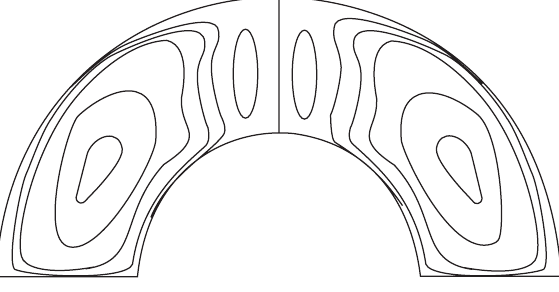
Figure 4.6. Contours of the meridional streamlines. Taylor vortex flow at Re = 600.